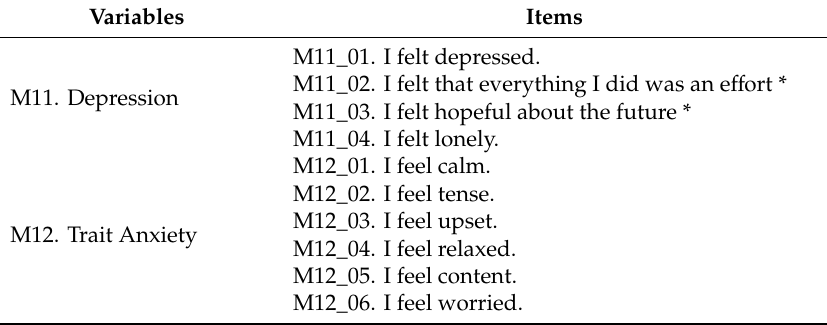
Table 2. Questionnaire items on depression and trait